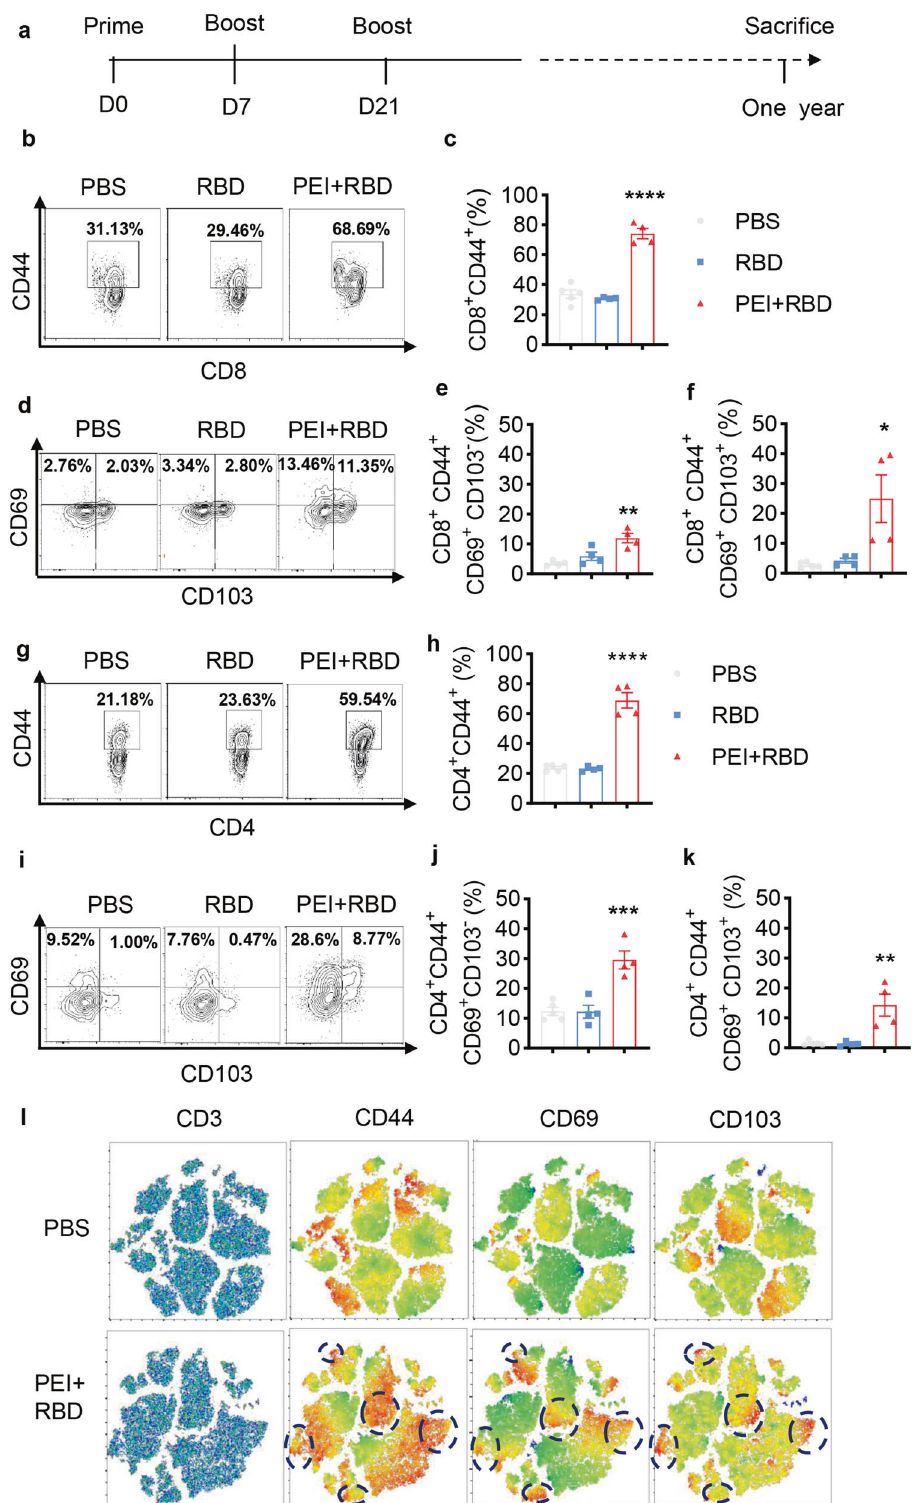
fi ngolimod (FTY720) starting two days before vaccination to block the egress of T cells from lymphoid organs (Fig. 6a). 27 Seven days after prime immunization, lung tissues were harvested and blood samples were collected for the analysis of T-cell responses and serum IgG titers, respectively. As expected, FTY720